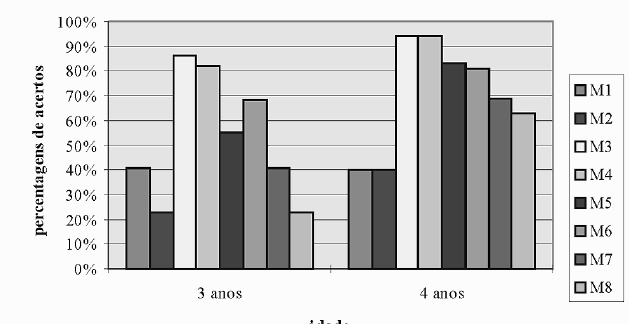
Figura 2 . Percentagens de acertos por idade de 3 e 4 anos.